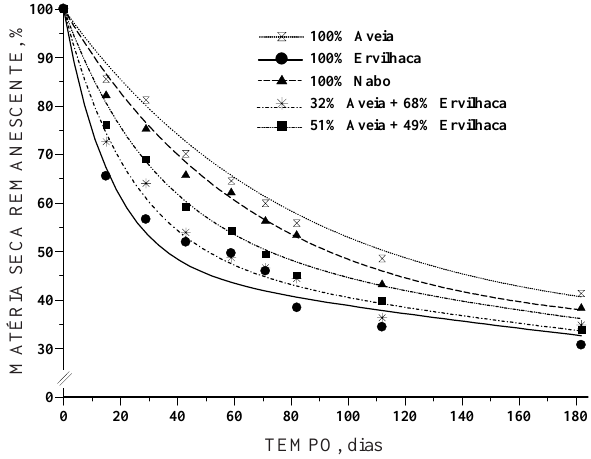
Figura 2. Matéria seca remanescente dos resíduos culturais de plantas de cobertura solteiras e consorciadas, em avaliações realizadas no campo até 182 dias após a distribuição das bolsas de decomposição na superfície do